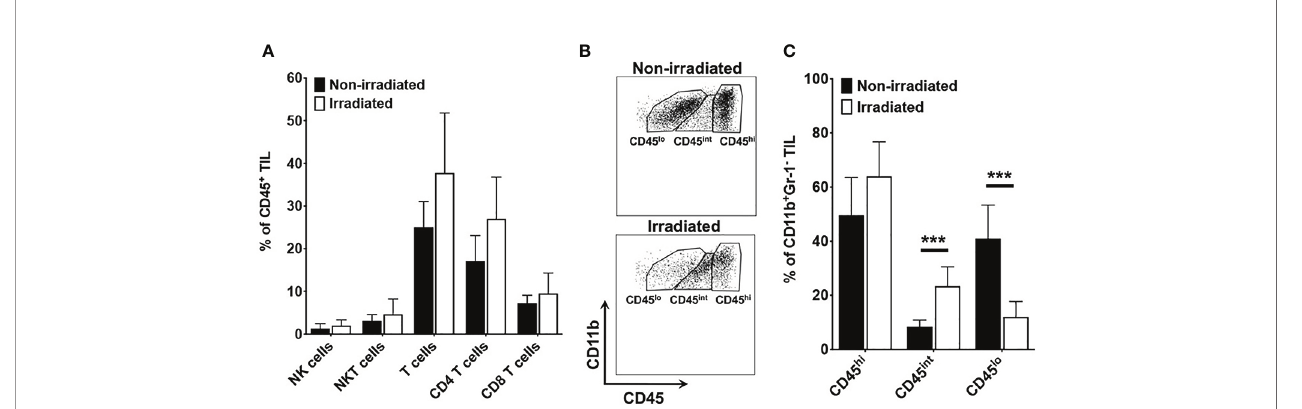
FIGURE 5 | (A) quanti fi es the relative frequency of CD45 + tumor-in fi ltrating leukocytes (TIL) that are NK cells (CD3 - NK1.1 + ), NKT (CD3 + NK1.1 + ), total T cells (CD3 + ), CD8 T cells (CD3 + CD8 + ), and CD4 T cells (CD3 + CD4 + ). (B) is a representative fl ow plot demonstrating the gating strategy to identify resting microglia (CD45 lo ), activated microglia (CD45 int ), and macrophages/monocytes (CD45 hi ). Cells are gated on lineage negative (i.e., Non-T cells, Non-NK cells), CD11b-positive, Gr-1- negative TIL). (C) quanti fi es the percentage of CD11b + Gr-1 - TIL that are CD45 hi , CD45 int , or CD45 lo . Data are representative of two independent experiments with 4-5 mice in each experiment. Black bars represent non-irradiated mice; white bars previously irradiated mice. Differences in CD45 int and CD45 lo are statistically signi fi cant (***p <